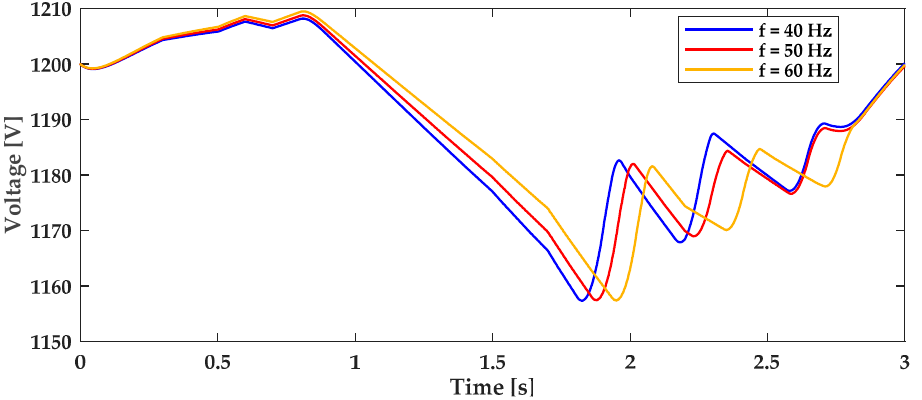
Figure 21. DC bus voltage stability with AC microgrid not dependent on frequency.